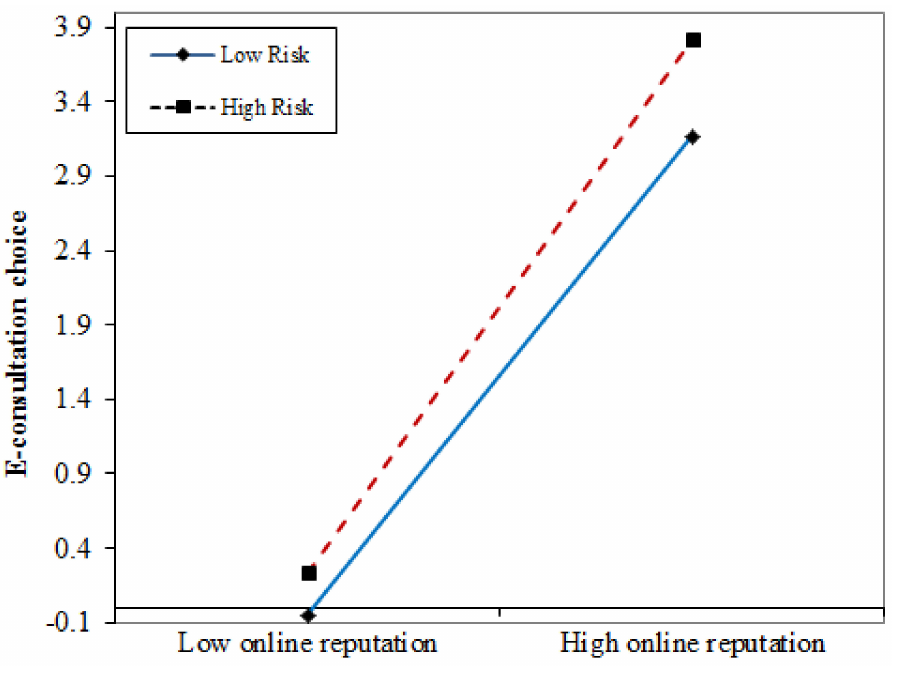
Figure 2. Interaction effect. Table 4. Robustness